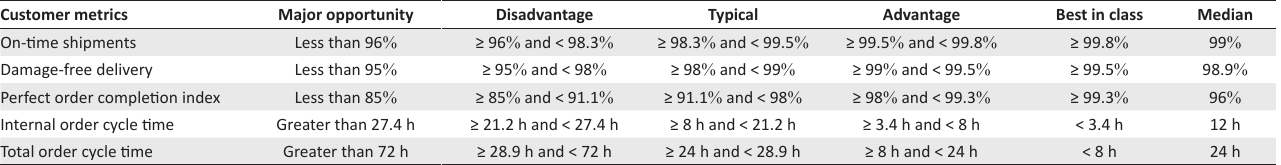
TABLE 3: Customer quintile benchmark